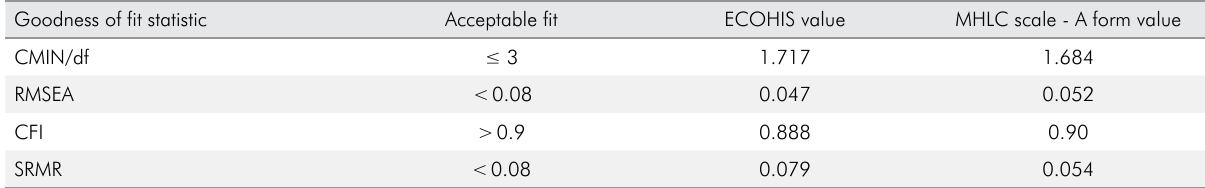
Table 5. Goodness of fit indices from confirmatory factor analyses of ECOHIS and MHLC scale-A form (n = 324). Goodness of fit